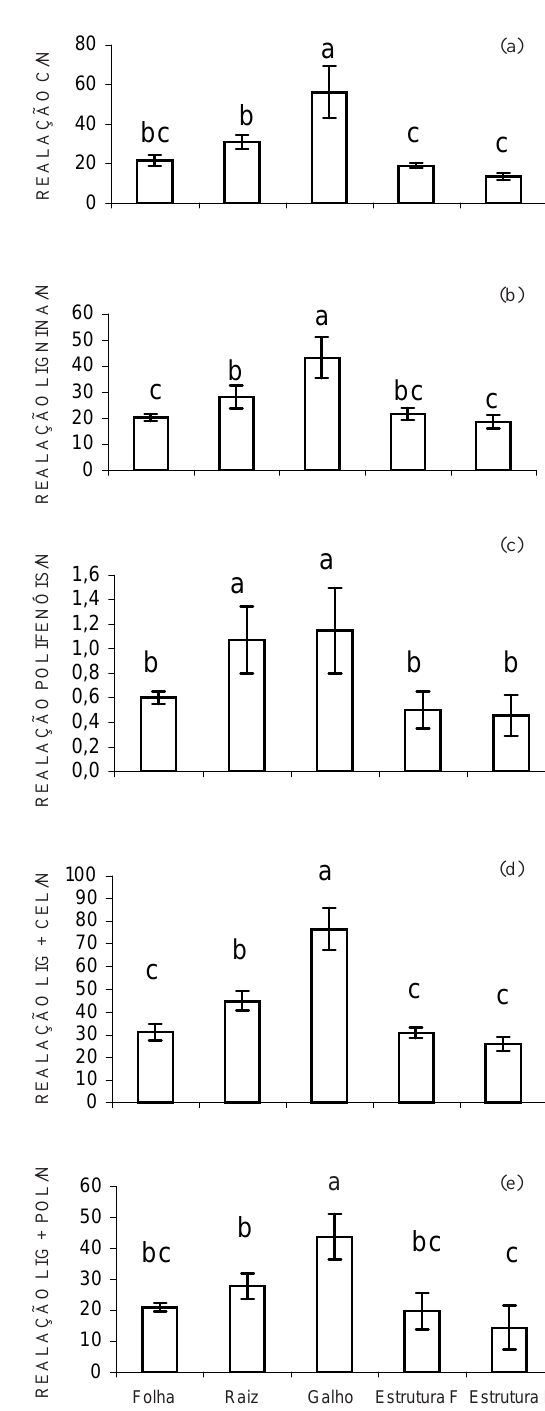
Figura 3. Relações referentes aos atributos qualita- tivos das diferentes estruturas da serapilheira: C orgânico/N total (C/N), lignina/N (lig/N), polifenóis/N (pol/N), lignina + celulose/N (lig + cel/N) e lignina + polifenóis/N (lig + pol/N).